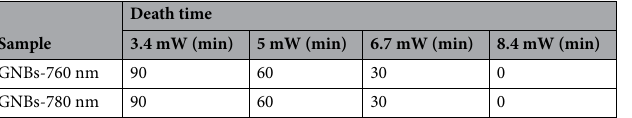
Table 4. Summary of the information about the continuous laser power and cell death time